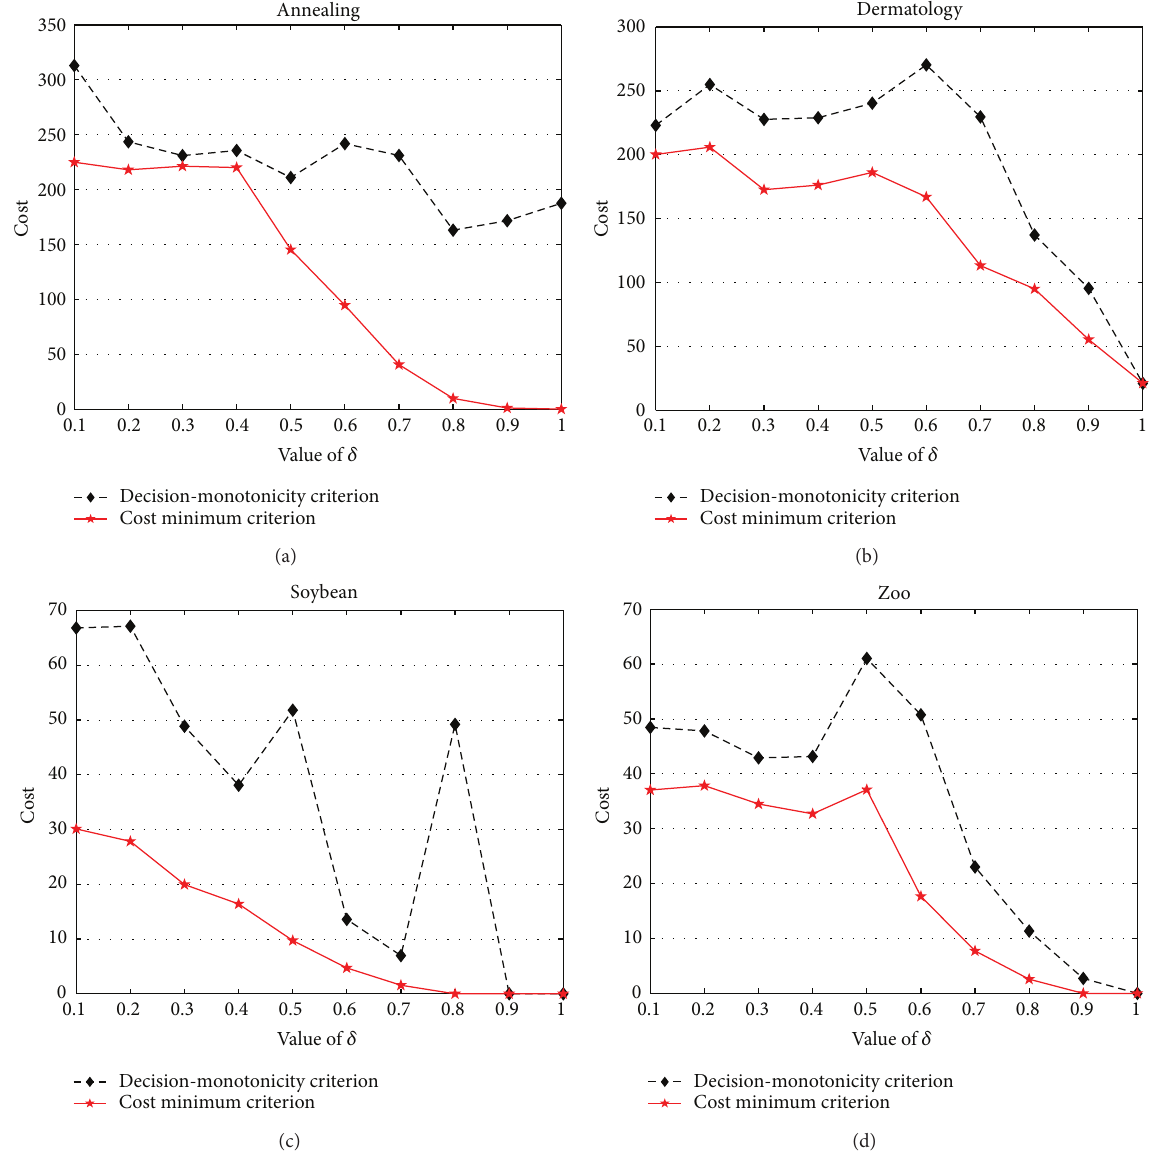
Figure 1: Reducts’ costs comparison between decision-monotonicity and cost minimum